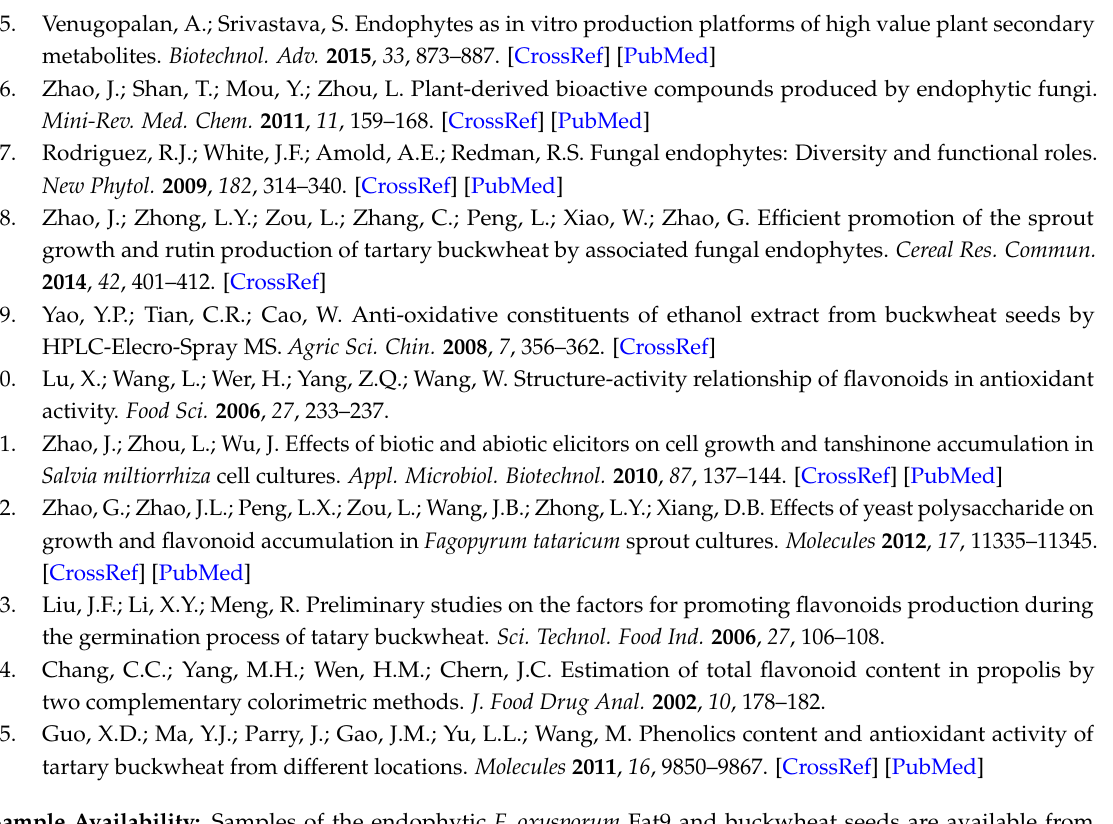
Sample Availability: Samples of the endophytic F. oxysporum Fat9 and buckwheat seeds are available from the